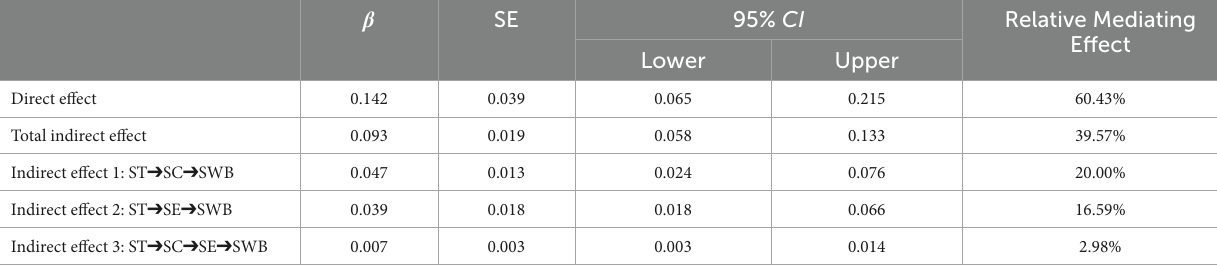
TABLE 2 Analysis of the mediation effects of self-compassion and social